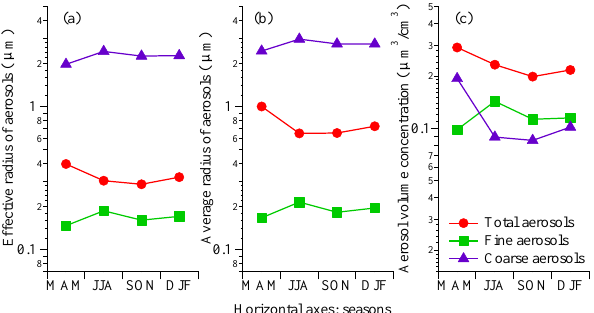
Figure 8. Seasonal variations in the effective ( a ) and mean ( b ) ra- dius of aerosols as well as the aerosol volume concentrations ( c ) in the all, fine and coarse modes in urban Nanjing.